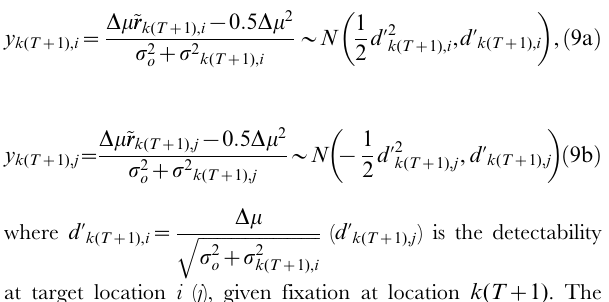
Figure S1 Three visibility maps used in present paper. Figure S2 The probability density function of natural images is estimated from empirical distributions. (a) Gaussian and Laplace distributions fit to the distribution of template responses to natural images. (b) Convolution of Laplacian distribution with a Gaussian internal noise distribution. Found at: doi:10.1371/journal.pcbi.1000930.s002 (0.15 MB TIF)